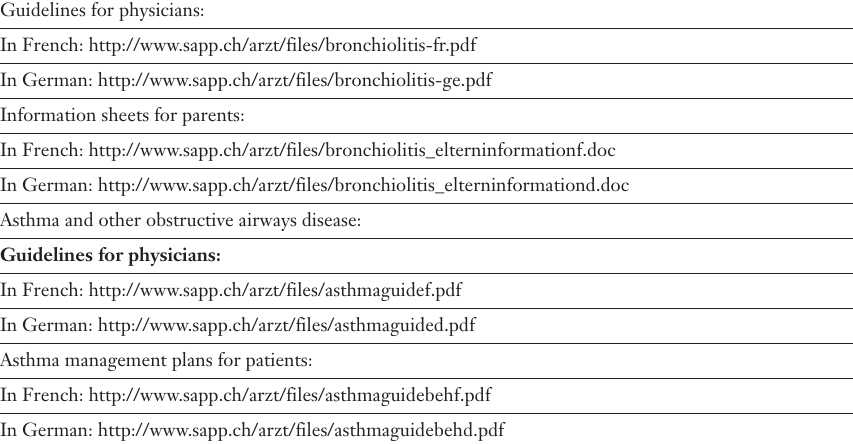
Table 1 Internet sites with recommendations of the Swiss Paedi- atric Pulmonology Group (SAPP) on the management of bronchiolitis, asthma and other obstructive airways disease in